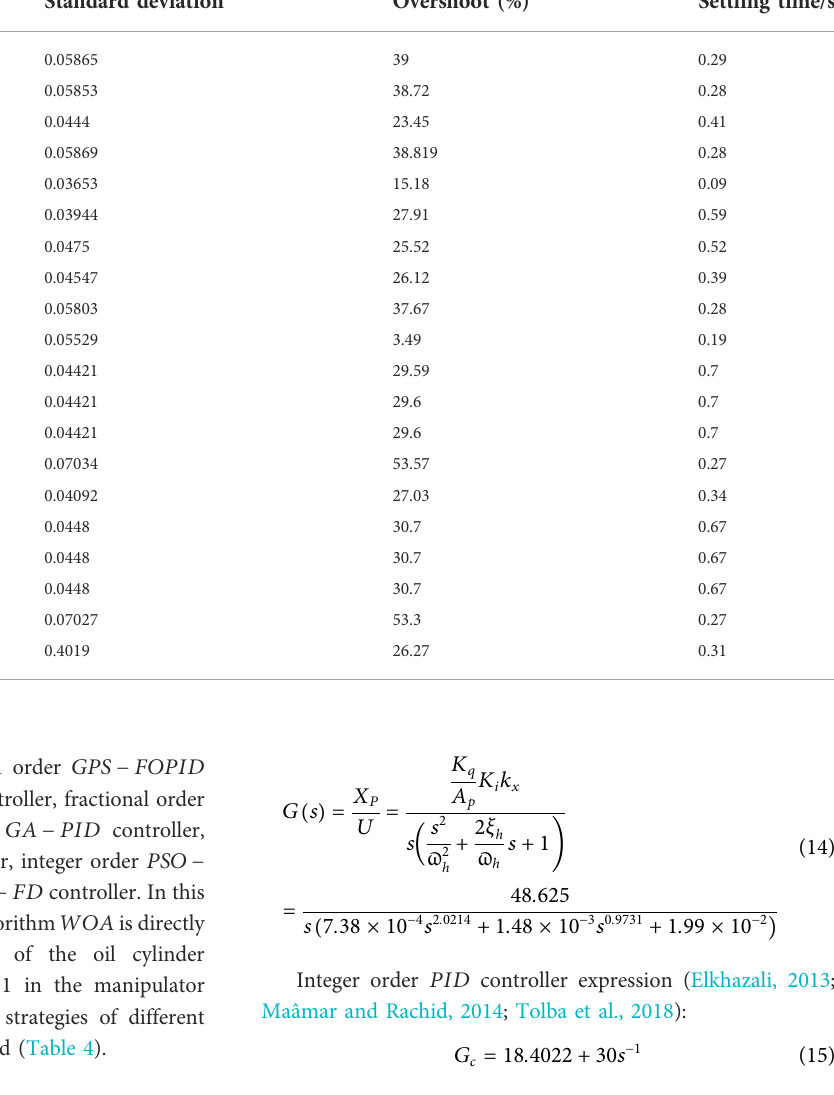
Figure 14 and Table 5 show that the PID controller is not fi t in complex systems, and the results show that it fails to ful fi ll fi ne- tuning, especially as the controlled object gradually stabilizes after 6.06s when the PID fractional order acts. In the complex system, the FOPID controller has a better control effect on the fractional order controlled object, and the overshoot is 8.672%, which can be settled in 0.02s. The DOA 090470 − 1 ( 1 ) hydraulic cylinder parameter is shown in Table 6.